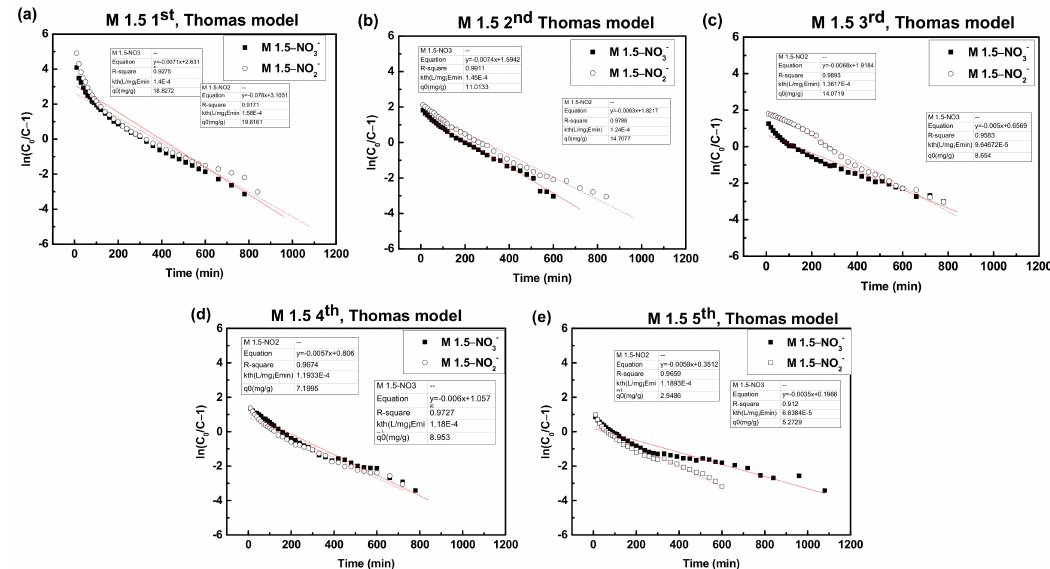
Figure 11. Thomas model fittings of nitrate and nitrite adsorption onto M 1.5 fixed bed column ( a ) first cycle, ( b ) second cycle, ( c ) third cycle (d)fourth cycle (e)fifth cycle. (flow rate = 3 mL/min, column packed with 3.0 g of M 1.5, at room temperature). Regeneration was conducted by 0.80 wt % NaCl solution at a flow rate of 10.00 mL/min for 50